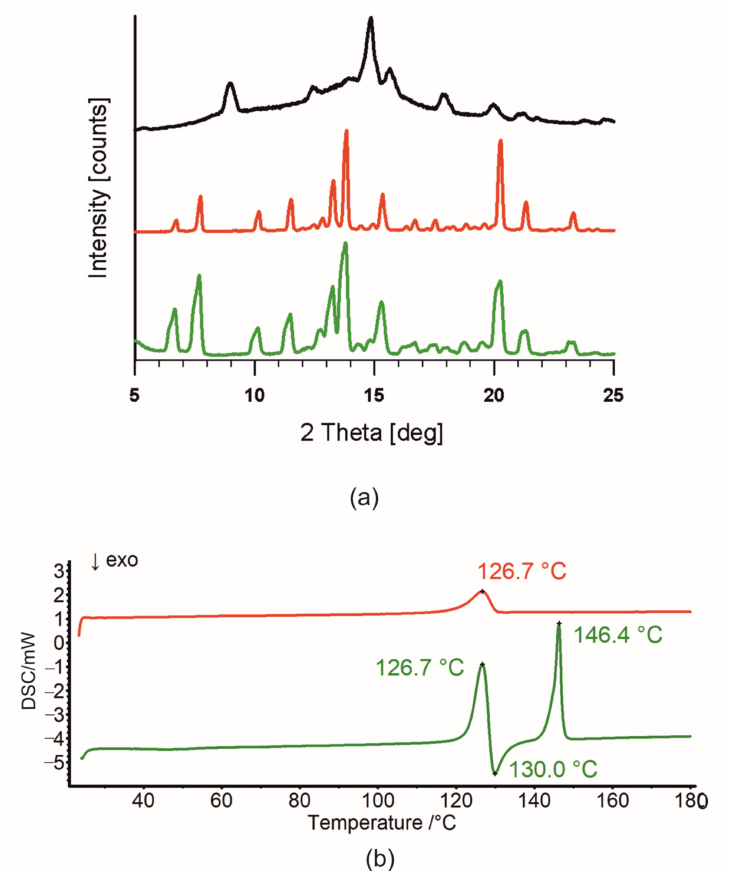
Figure 5. Green and red PXRD diffractograms ( a ) of R 3-but-OA samples used for DSC measurements shown in ( b ). The black pattern in ( a ) was registered after heating of “green” sample to 130 ◦ C. The red PXRD pattern corresponds to the red thermogram and green to